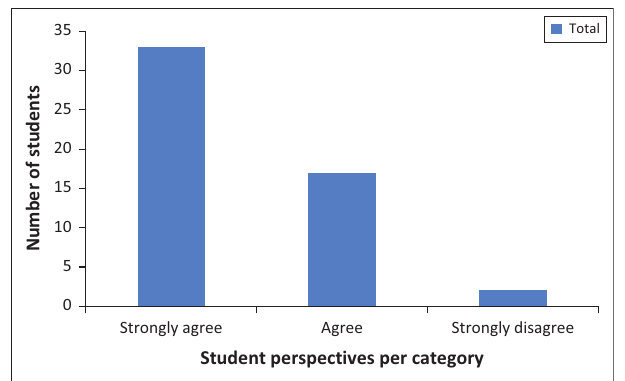
FIGURE 3: Necessity of workshops to assist students’ approach to assignments. FIGURE 4: Medical students’ performance on critical reflective essay